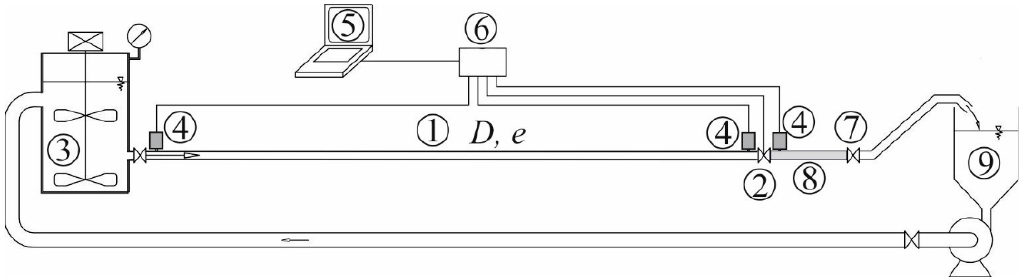
Figure 1. Schematic layout of the experimental facility.